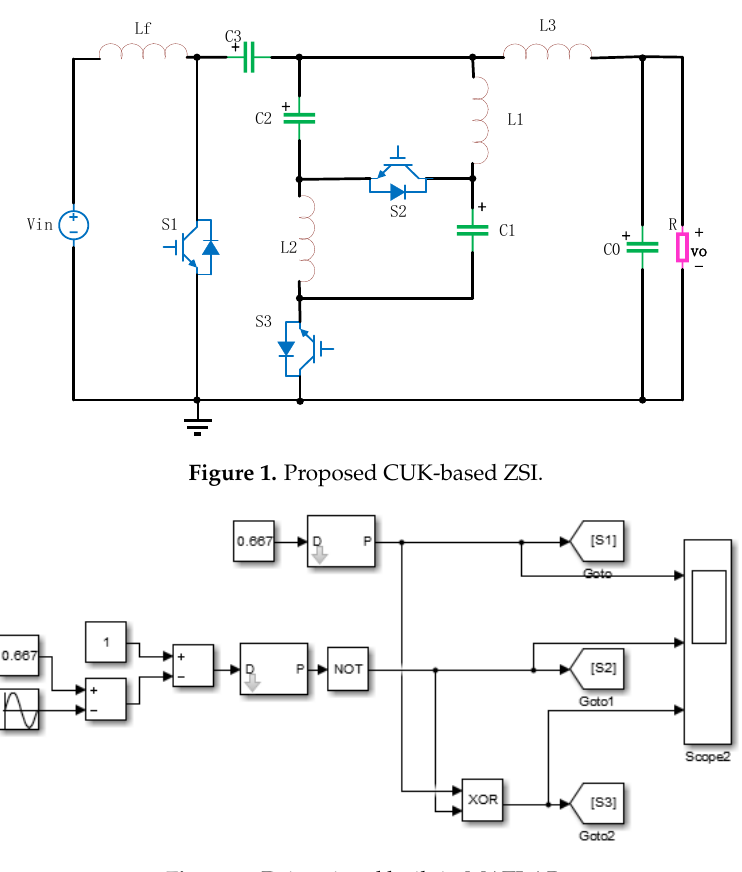
Figure 2. Drive signal built in MATLAB.